Question: Does the figure show an increasing or a decreasing trend?
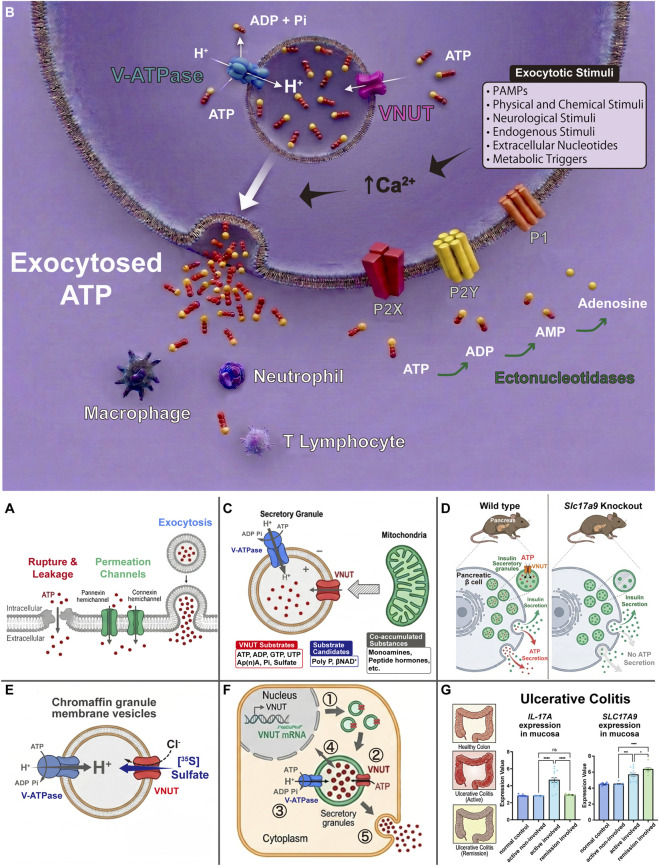
Answer: decreasing